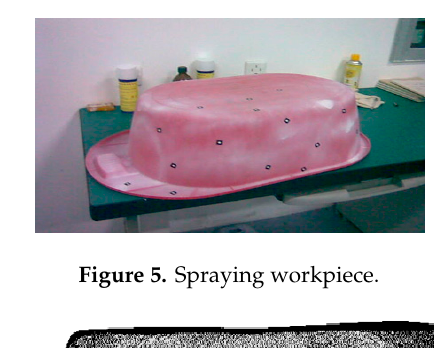
Figure 5. Spraying workpiece.